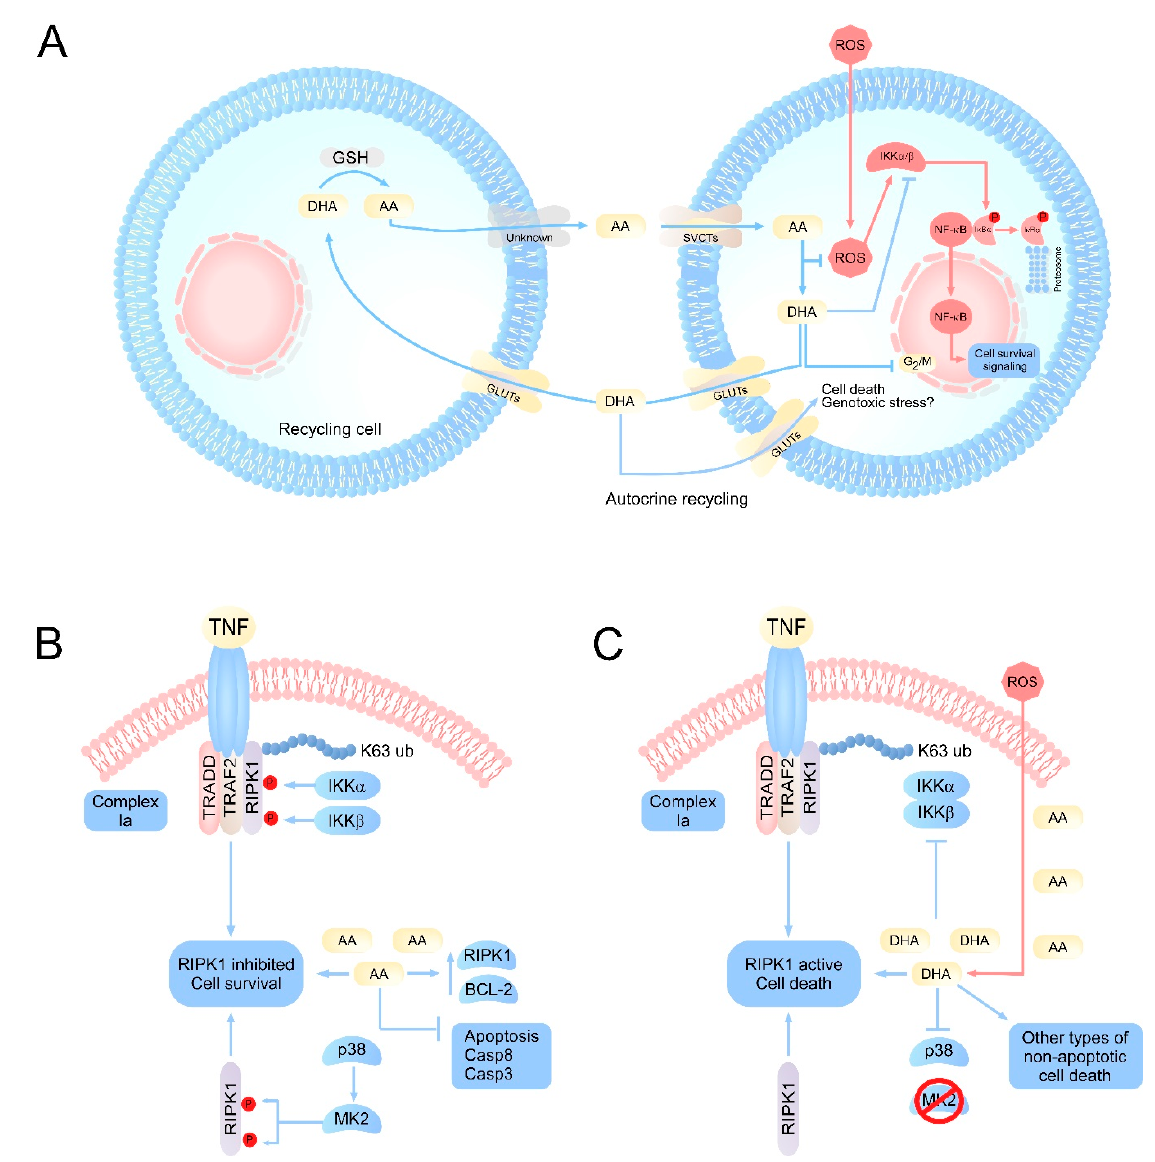
Figure 1. Integrative vision of the principal molecular pathways regulated by vitamin C. ( A ) Scheme of vitamin C recycling in normal cells or cells with oxidative stress. Under normal conditions, AA concentrations remain homeostatically stable due to the efficient recycling of DHA by specialized cells. However, under conditions of oxidative stress or inefficient recycling, an accumulation of intracellular DHA can occur. DHA would target the inhibition of IKK α / β , metabolic enzymes such as GAPDH, as well as the production of genotoxic stress, resulting in the induction of cell death. ( B ) Intracellular effects of vitamin C on signaling pathways associated with cell death. The physiological levels of AA would have a protective function intracellularly, favoring the inhibition of apoptosis by inducing overexpression of antiapoptotic genes, as well as caspases. At the same time, AA could maintain RIPK1 in its inhibited state, which favors cell survival. ( C ) Under pathophysiological or acute oxidative stress conditions, ROS overload induces a massive oxidation of AA to DHA, intracellularly. The accumulation of DHA results in the inhibition of IKK α / β , and p38, which can trigger the activation of RIPK1 and cell death due to necroptosis, in cells that accumulate high concentrations of vitamin C, such as neurons. AA: ascorbic acid; DHA: dehydroascorbic acid; SVCT2s: sodium-dependent vitamin C transporter; GLUTs: glucose transporters; RIPK1: receptor-interacting serine/threonine-protein kinase 1; MK2: p38MAPK-activated protein kinase 2; TRADD: TNFR1-associated death domain protein; TRAF2: TNF receptor associated factor